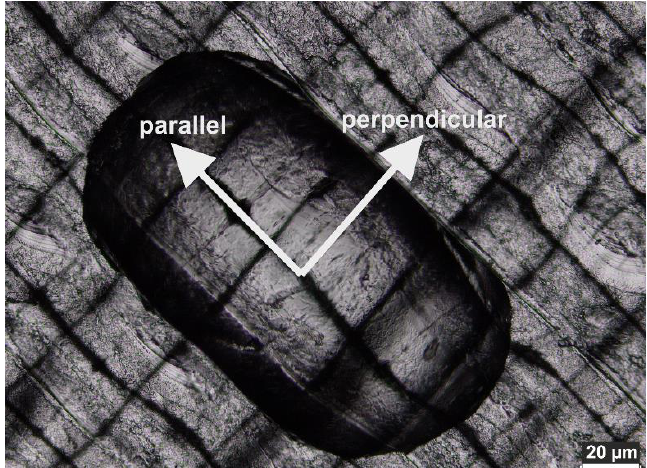
Figure 6. Anisotropic shape of water drop on a 3D printed surface. The terms “parallel” and “perpendicular” indicate drop orientation with respect to printing direction.